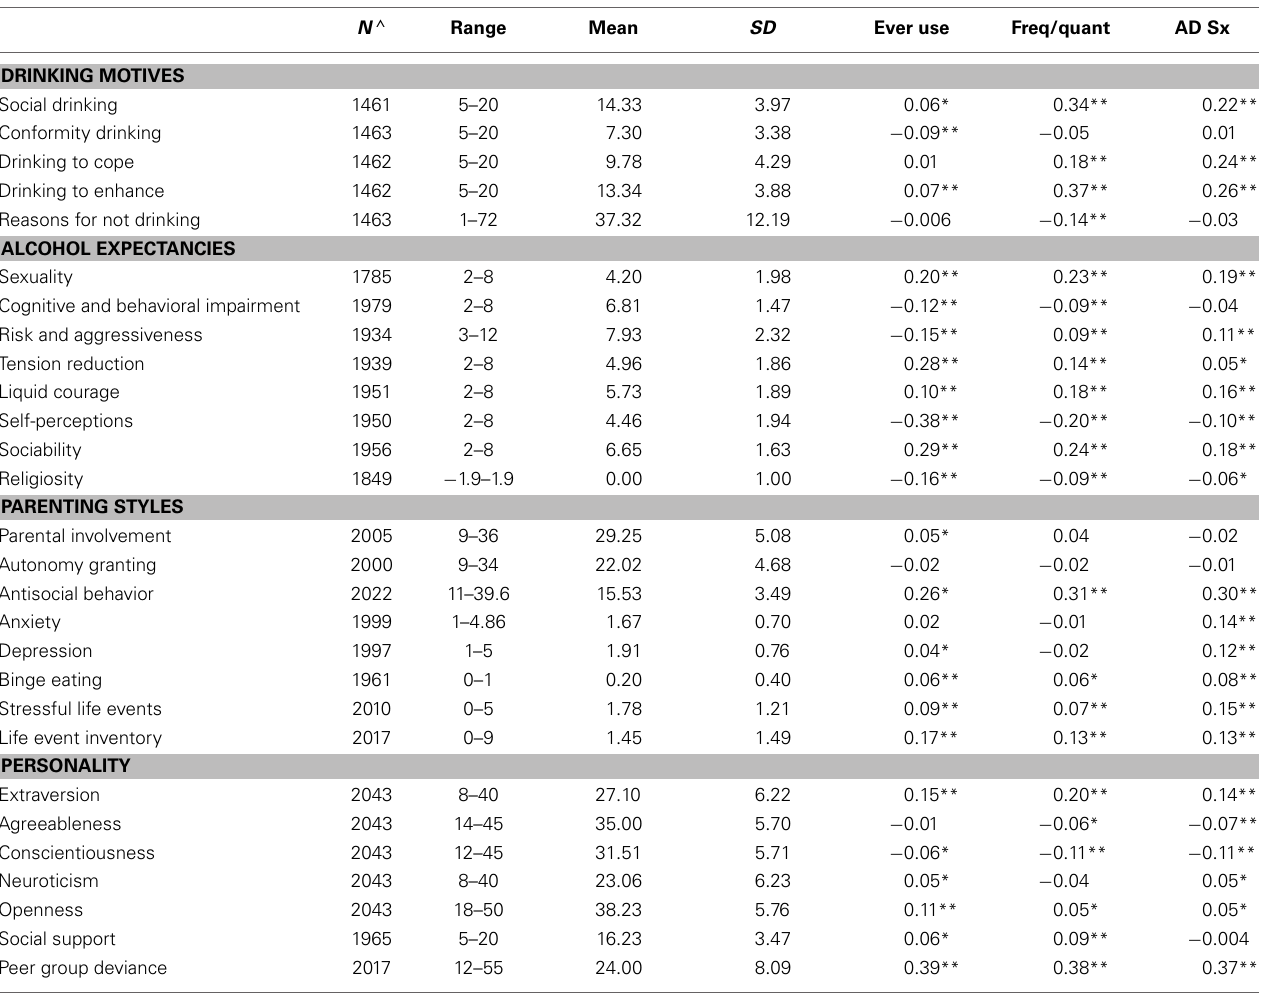
Table 5 | Means, standard deviations, and correlations with alcohol variables.